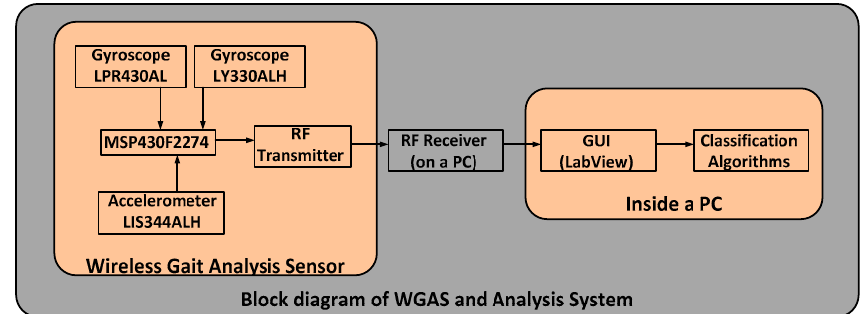
Figure 2. A simplified block diagram of the gait analysis/classification system using our WGAS.